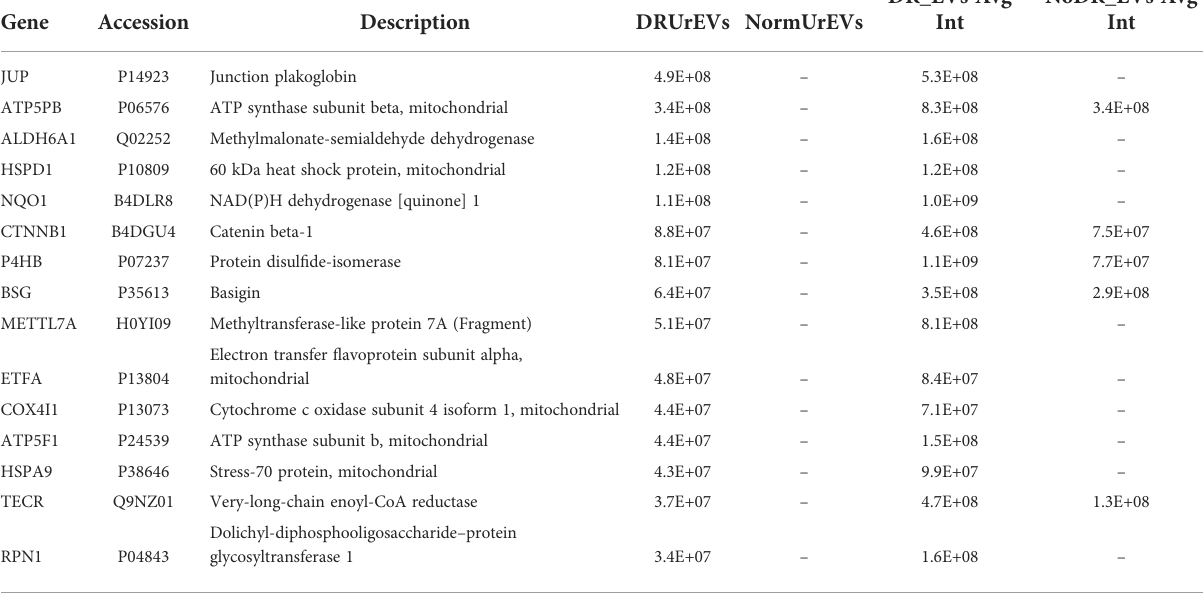
TABLE 3 57 proteins detected both in diabetic retinopathy extracellular vesicles released from human retina tissue and diabetic retinopathy urinary extracellular